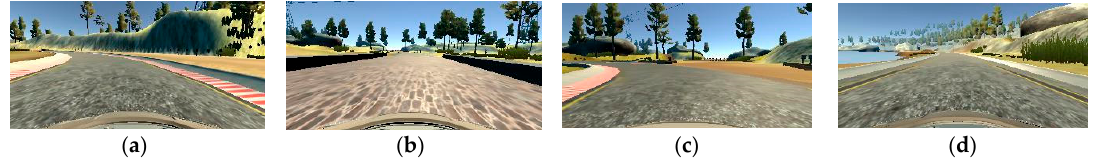
Figure 8. Input data captured in different frames using the central camera. During the representative track, the different road characteristics and the borders are presented. The four main track borders and road characteristics are: ( a ) red and white stripe—mostly sharp curves; ( b ) a small wall—the bridge with different road texture; ( c ) red and white stripe on one side and dirt on the other side—curves; ( d ) shoulders—mostly straight road.